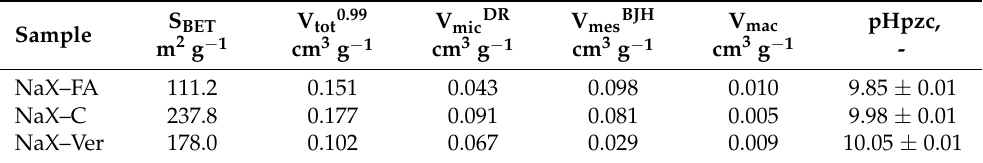
Table 2. Summary of textural parameters and the pHpzc of investigated zeolites. Sample